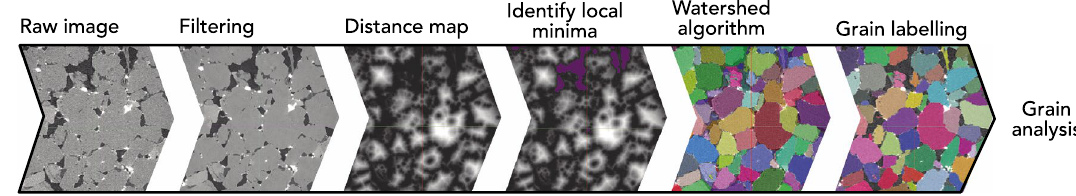
Figure 1. Schematic diagram showing the typical steps in grain identification using a watershed technique on CT images. Figure created using Fiji 2.1.0 42 and PerGeos 1.7.0: https:// www. therm ofish er. com/ uk/ en/ home/ elect